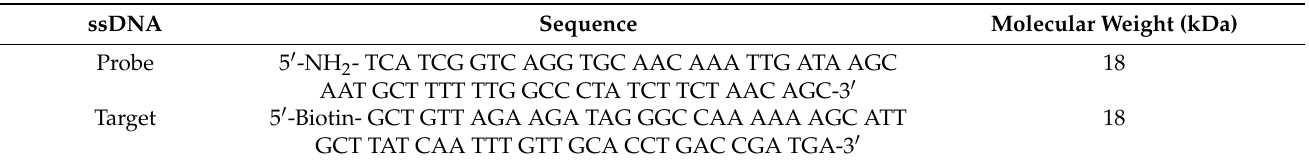
Table 2. Sixty base DNA sequences as probe and target molecules and their molecular weights. ssDNA Sequence Molecular Weight